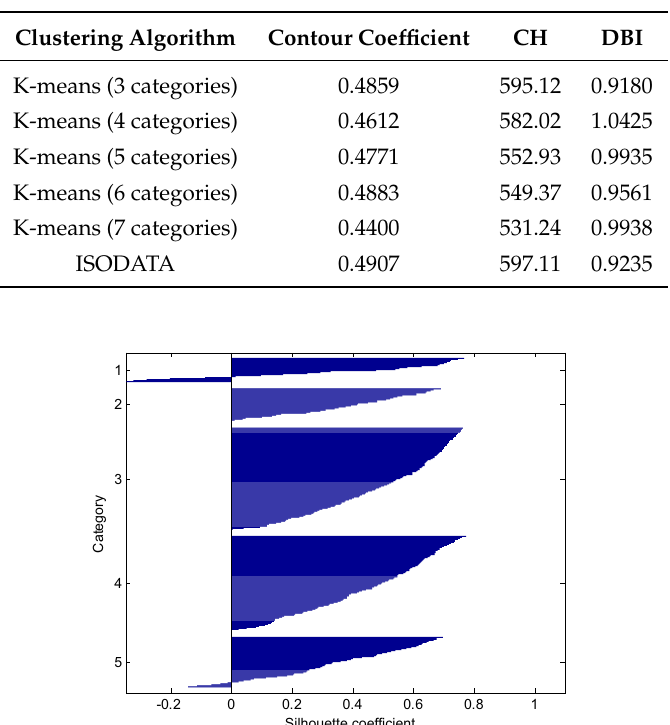
Table 4. Evaluation index of clustering effect by K-means and ISODATA method.